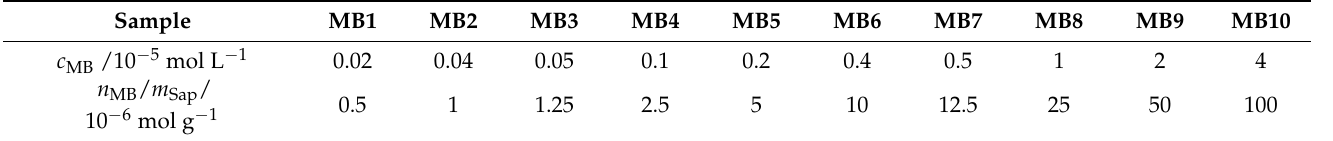
Table 3. Final compositions of the colloidal dispersions of organoclays MB1-MB10 used for the preparation of organoclay films.